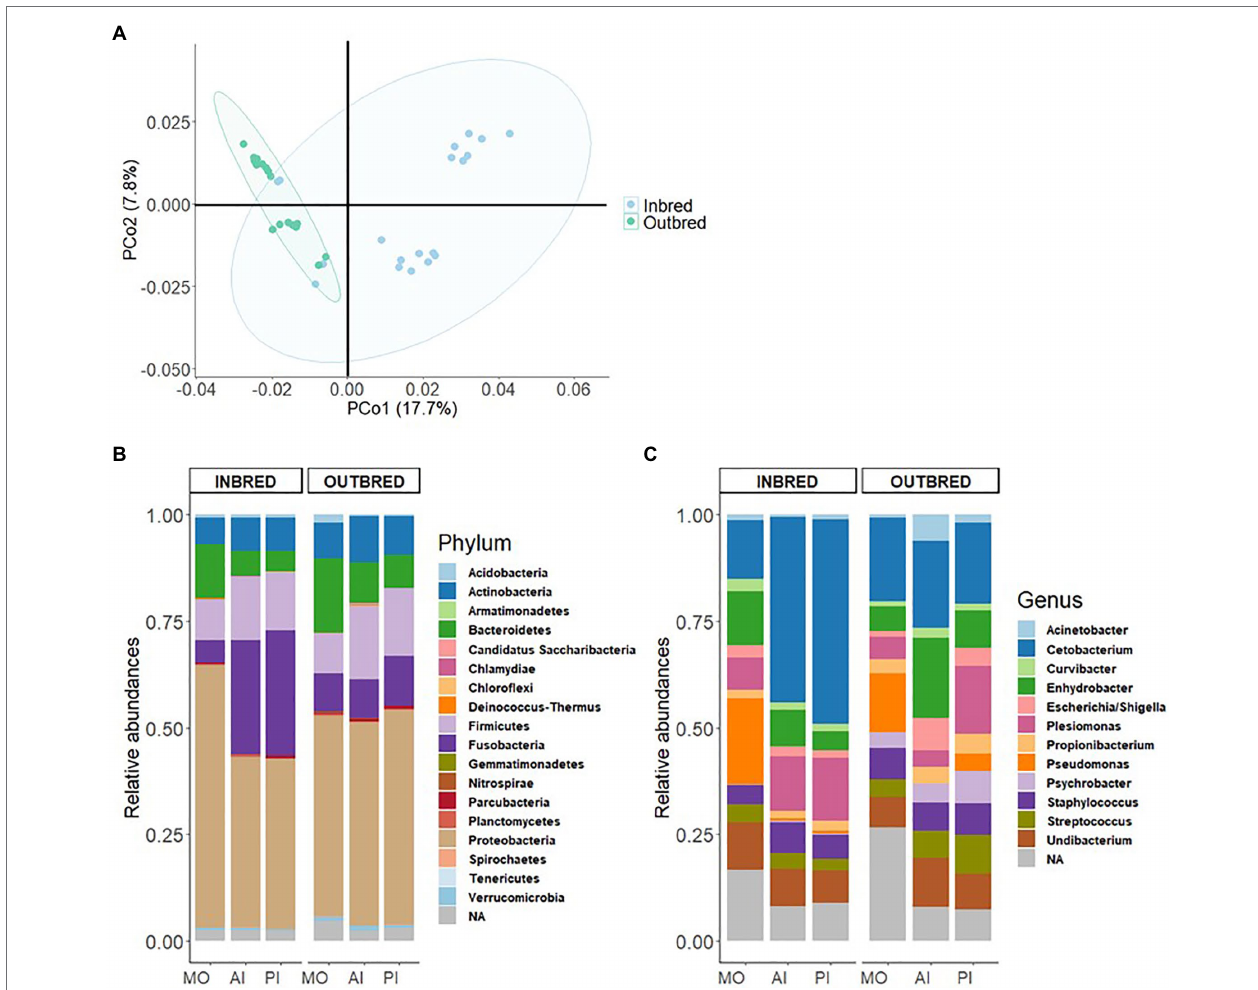
FIGURE 1 | Genetic differentiation and microbiome in the inbred and outbred groups of Nile tilapia. (A) Principal coordinates analysis (PCoA) plot based on 6,825,083 SNPs of the inbred and outbred groups. The ellipses were generated assuming that the data are from a multivariate normal distribution. (B) Phylum- level relative abundance of the microbial composition in the inbred and outbred groups. (C) Relative abundance of top 12 genera in the inbred and outbred